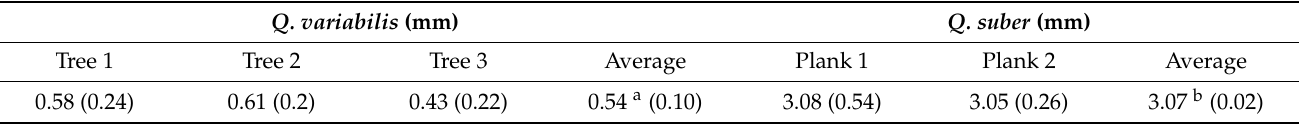
Table 2. Growth ring widths of Q. variabilis virgin cork and Q. suber reproduction cork. Q. variabilis